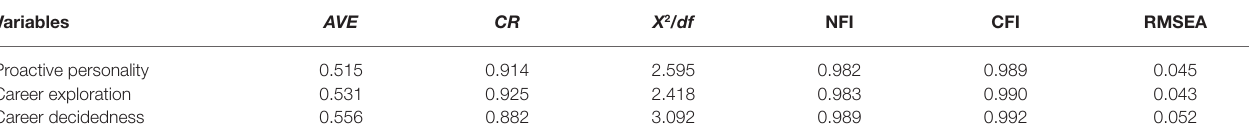
TABLE 3 | Structure validity.